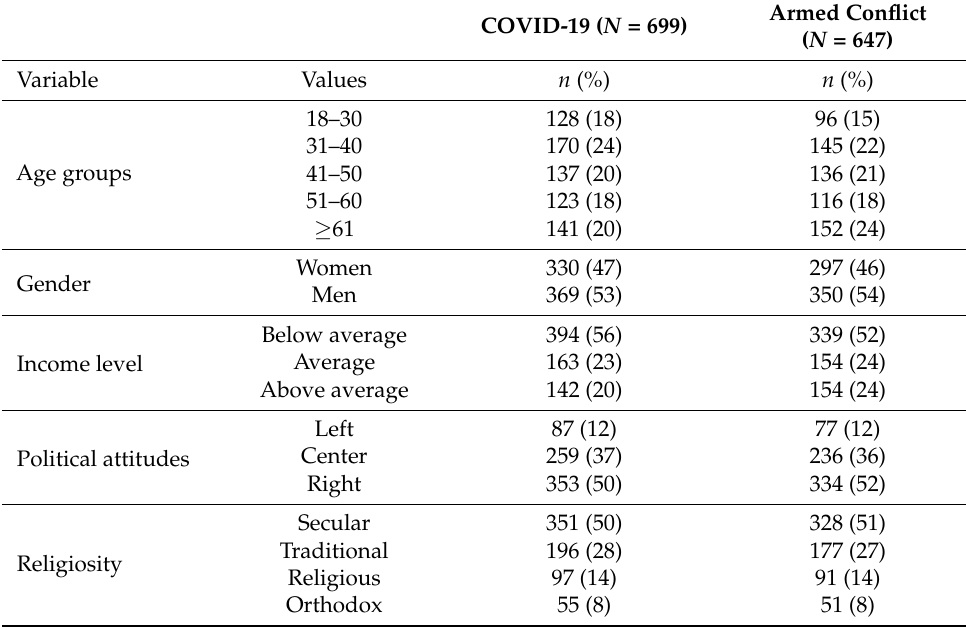
Table 1. Demographic characteristics of the